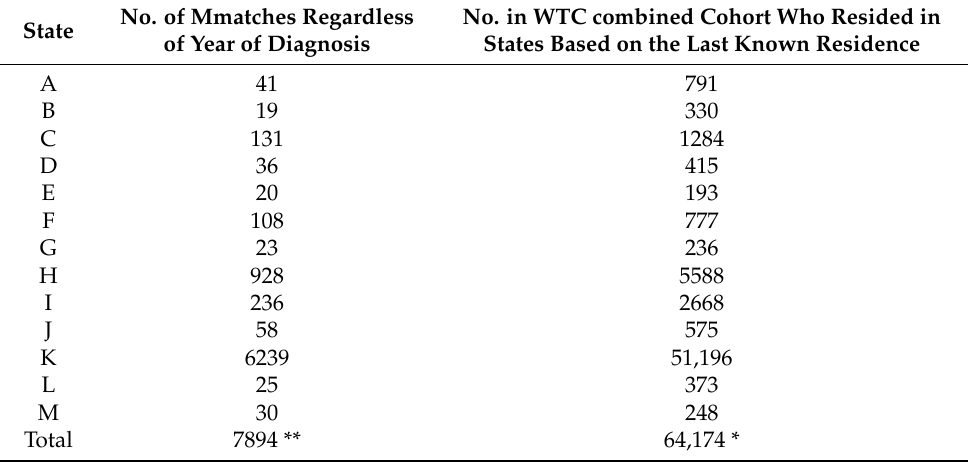
Table 3. Tumor matches for 13 state cancer registries.